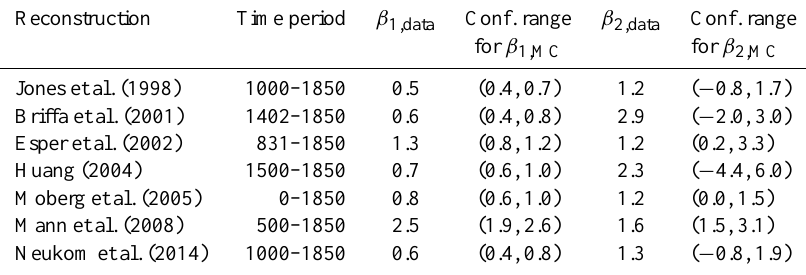
Table 1. Results using approach 1 for multiproxy temperature reconstructions.